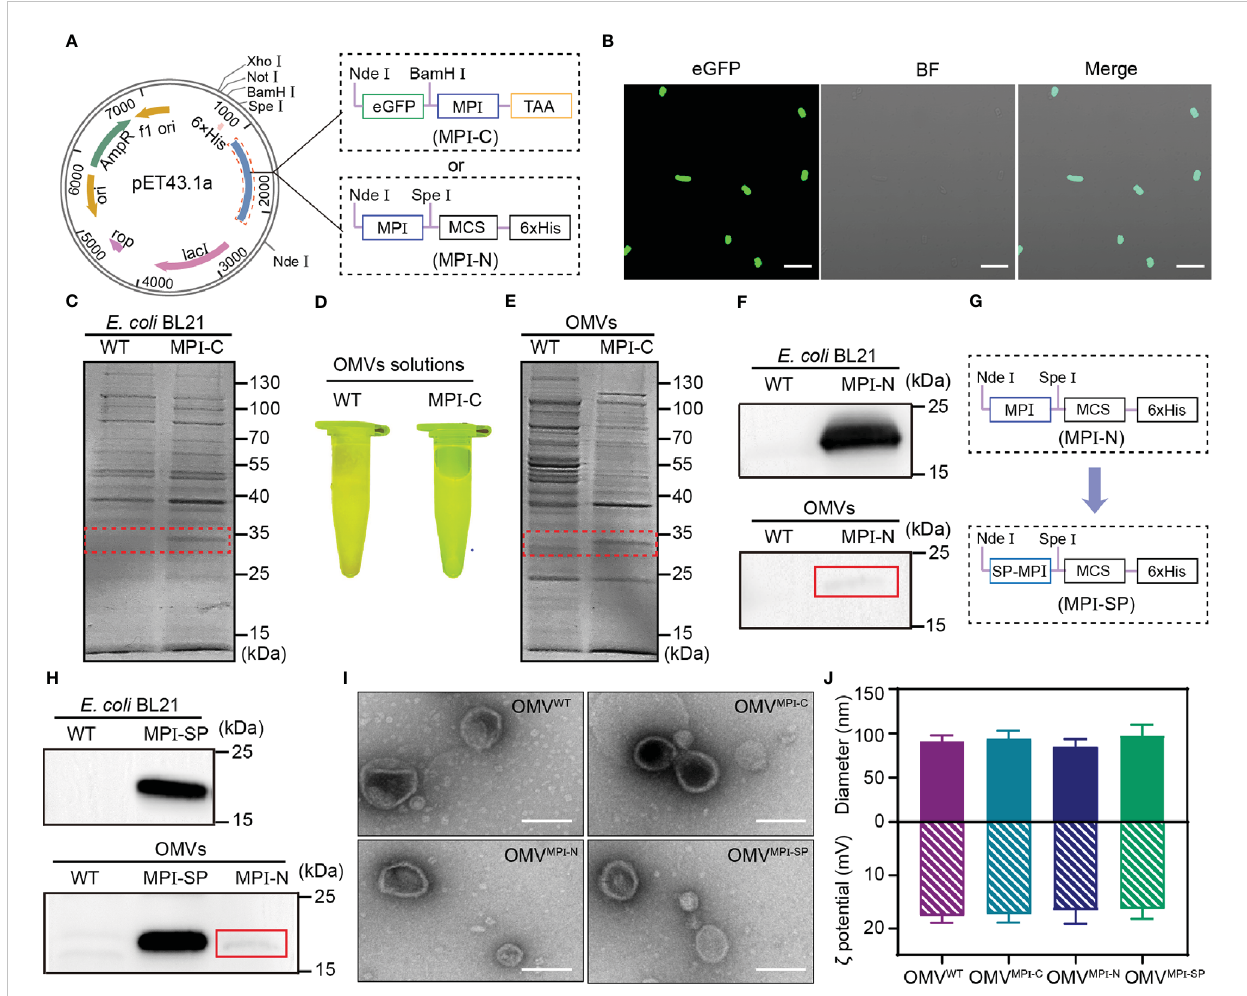
FIGURE 1 Preparation and characterization of OMVs. (A) Schematic representation showing constructions of pET43.1a-MPI-C and pET43.1a-MPI-N. (B) CLSM images of transformed E. coli (BL21) expressing eGFP-MPI (MPI-C) fusion peptide. BF, bright fi eld. Scale bars = 10 m m. (C) SDS-PAGE analysis of total proteins from WT and transformed E. coli (BL21) expressing MPI-C fusion peptide. The red dashed box indicates the position of MPI-C. (D) Fluorescence image of OMV WT and OMV MPI-C solutions excited by blue light. (E) SDS-PAGE analysis of total proteins from OMV WT and OMV MPI-C . The red dashed box indicates the position of MPI-C. (F) Western blot analysis of MPI-N expressions in transformed E. coli (BL21) and the corresponding OMVs. The red line box indicates the slight band of MPI-N. (G) Schematic representation of pET43.1a-MPI-SP construction. (H) Western blot analysis of MPI-SP expression in transformed E. coli (BL21) and the corresponding OMVs. MPI-N expression in OMVs shown in the bottom panel is used as a control. The red line box indicates the slight band of MPI-N. (I) TEM images of OMV WT , OMV MPI-C , OMV MPI-N , and OMV MPI-SP . Scale bars = 100 nm. (J) Histogram showing hydrodynamic sizes and zeta potentials of OMV WT , OMV MPI-C , OMV MPI-N , and OMV MPI-SP . Measurements with DLS were repeated three times. Data are presented as mean ±